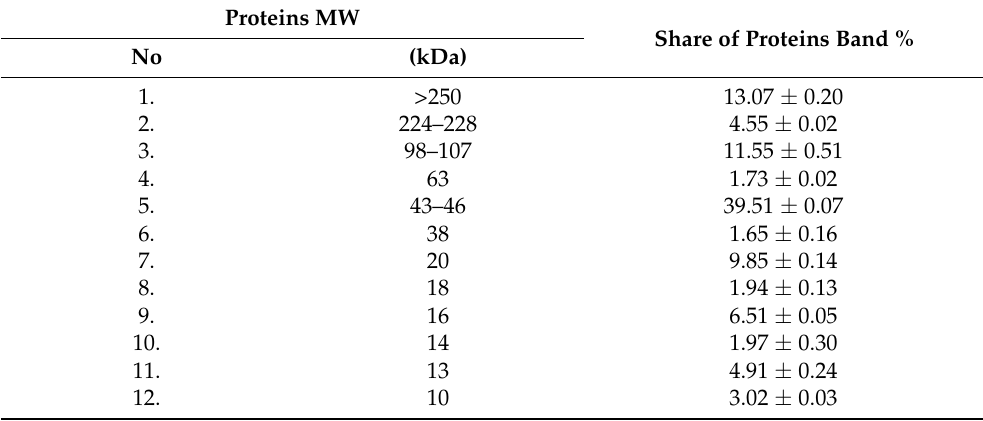
Table 4. Molecular weight and percentage share of the protein bands marked in S. woodiana mus- sel powder.